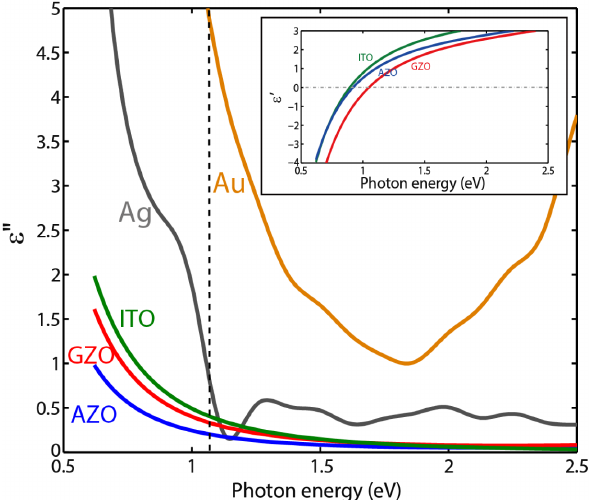
FIG. 1 (color online). Optical loss or imaginary part of permittivity of three transparent conducting oxides: ITO, AZO, and GZO, compared with that of gold and silver. Optical constants of thin films of AZO, GZO, and ITO are from Ref. [13], and those of gold and silver are from Ref. [14]. The inset shows the real part of permittivity of AZO, GZO, and ITO. The vertical dashed line corresponds to the photon energy where real permittivity of GZO crosses zero.